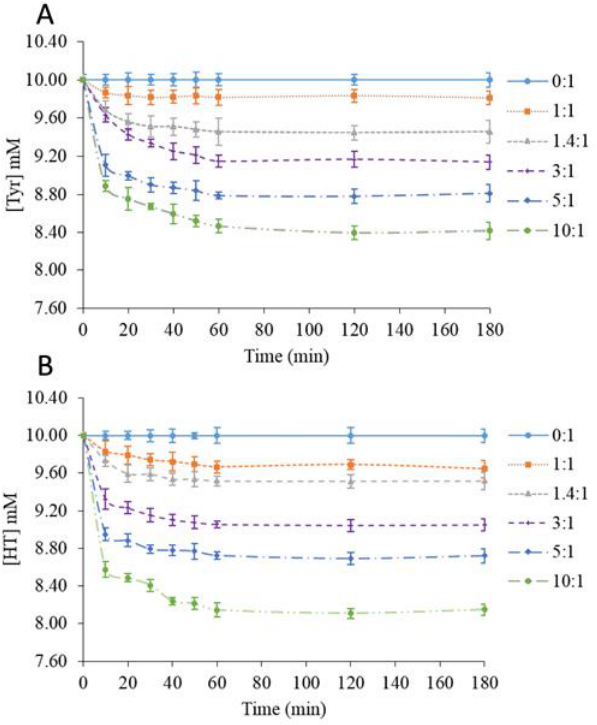
Figure 1. Time-dependence of tyrosol ( A ) and hydroxytyrosol ( B ) concentration according to the β -CD/phenol molar ratio.